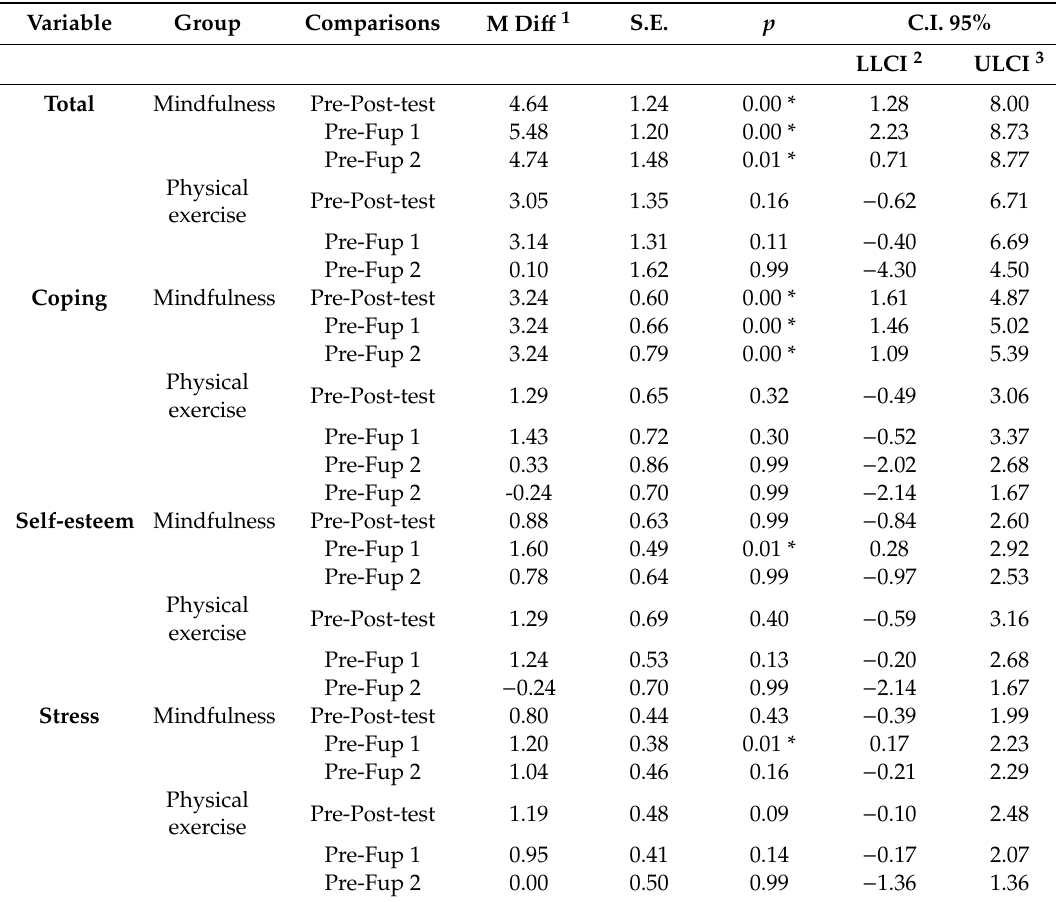
Table 4. Comparisons of simple e ff ects—time factor